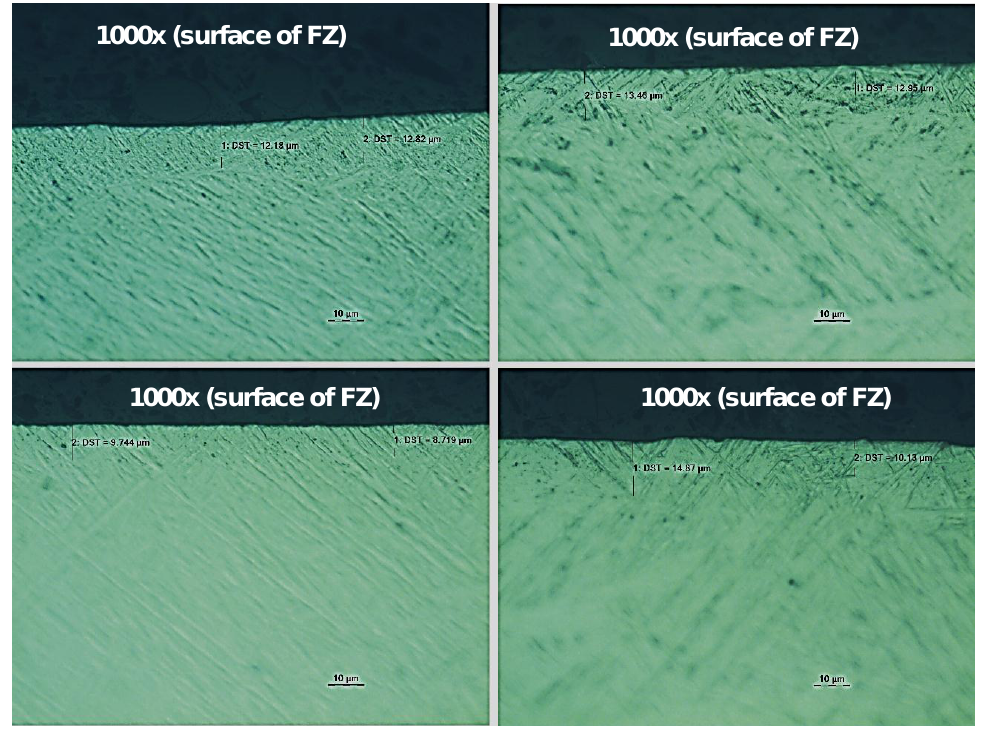
Figure 6. Metallographic images of Ti 6 Al 4 V-LR samples at the external surface.